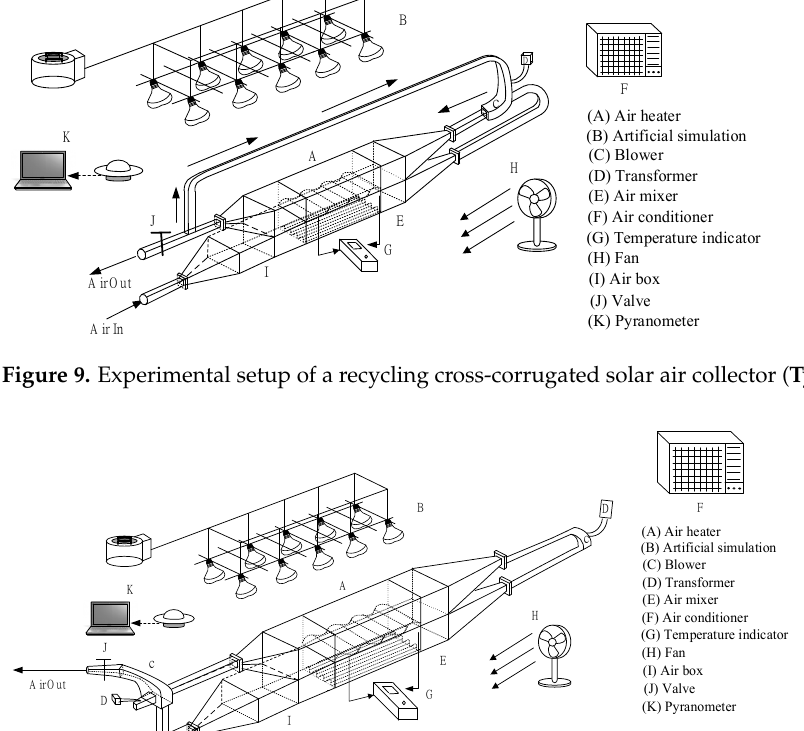
Figure 8. Experimental setup of a recycling cross-corrugated solar air collector ( Type B ).